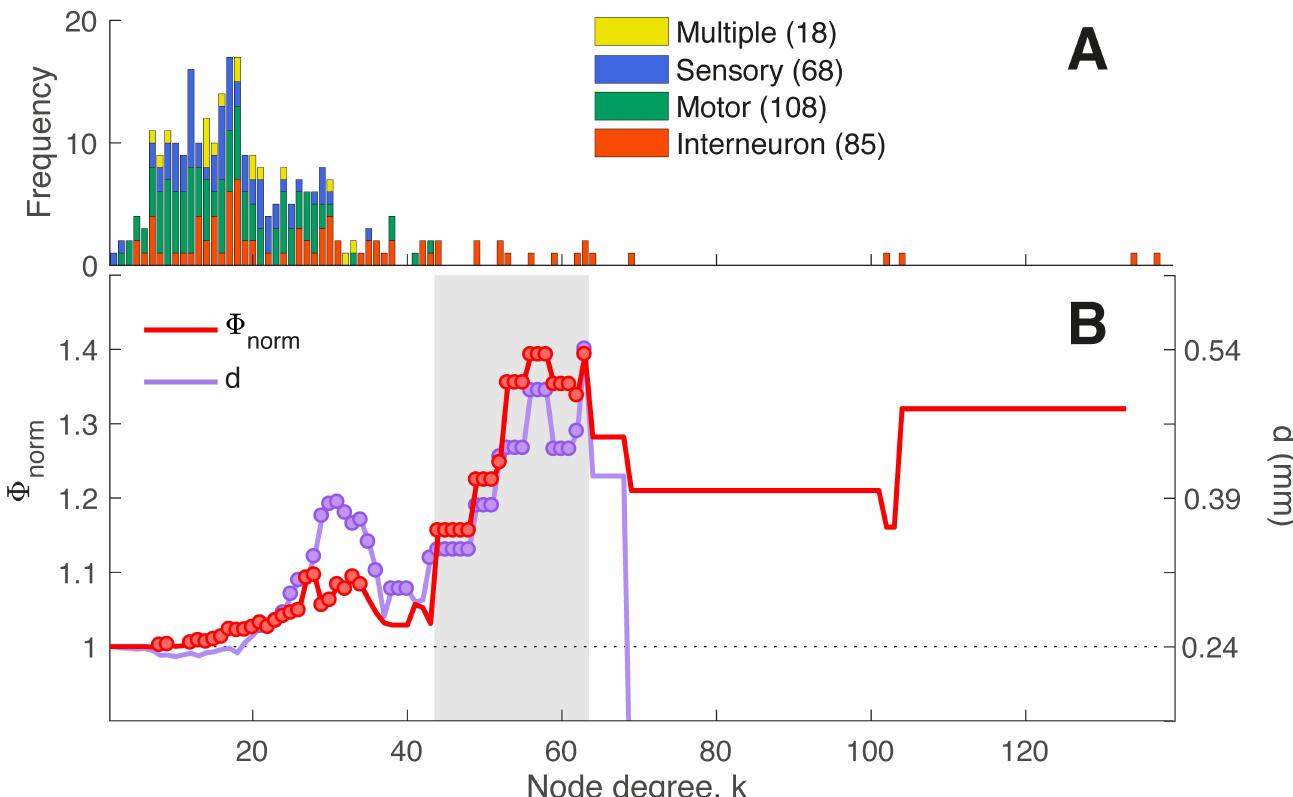
Fig 5. Rich-club organization of the C. elegans connectome. (A) Degree distribution of neurons, labeled to four categories: (i) interneuron (85 neurons, orange), (ii) motor (108 neurons, green), (iii) sensory (68 neurons, blue), or (iv) multiple assignments (18 neurons, yellow). The distribution features an extended tail of high-degree interneurons. (B) Normalized rich club coefficient, F norm (red), as a function of the degree, k , at which hubs are defined (as neurons with degree > k ). Also shown is the mean Euclidean separation distance, d (purple) between connected hub regions (across degree thresholds, k ). F norm > 1 indicates that hubs are more densely interconnected among each other than expected by chance, with red circles indicating values of F norm that are significantly higher than an ensemble of 1 000 degree-matched null networks ( p < 0.05). Purple circles indicate where the Euclidean distance between connected pairs of hubs is significantly greater than the Euclidean distance for all other pairs of connected regions (right-tailed Welch’s t -test, p < 0.05). Fig 5A, where neurons are labeled as sensory neurons, interneurons, motor neurons, or neu- rons with multiple functional assignments. Consistent with the results of Towlson et al. [28],